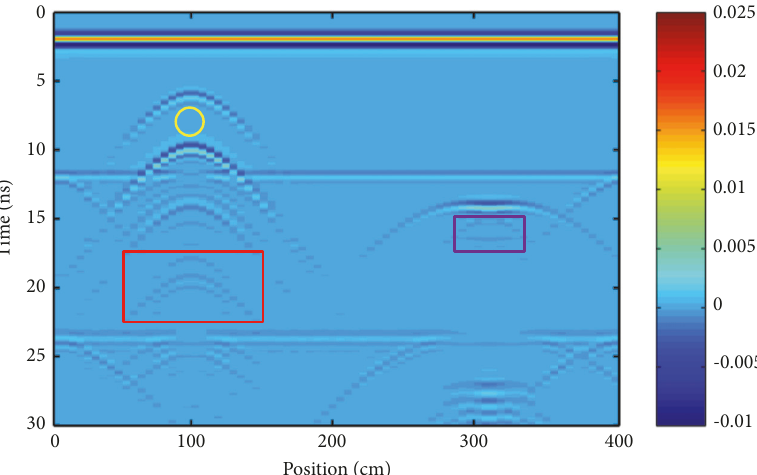
Figure 16: The wiggle trace profile of the three-layer pavement model simulated by the CUDA-implemented nonconformal SPRK methods.